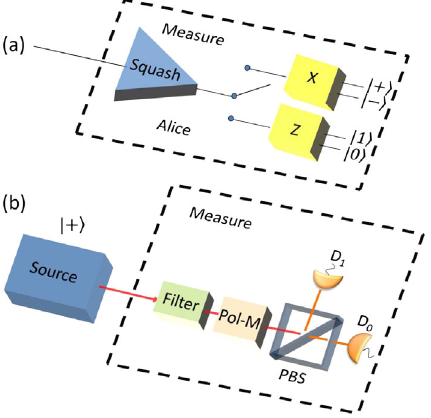
FIG. 2. (a) Measurement model for SIQRNG. The quantum state first passes through a squasher and is projected as either a qubit or a vacuum. Then, the output qubit is measured in the X or Z basis chosen by an active switch. There are two outcomes for each basis measurement, corresponding to the two eigenstates of the basis. (b) An optical implementation of the SIQRNG in (a), as discussed in Sec. III A. Here, Pol-M refers to a polarization modulator, PBS refers to a polarizing beam splitter, and D 0 and D